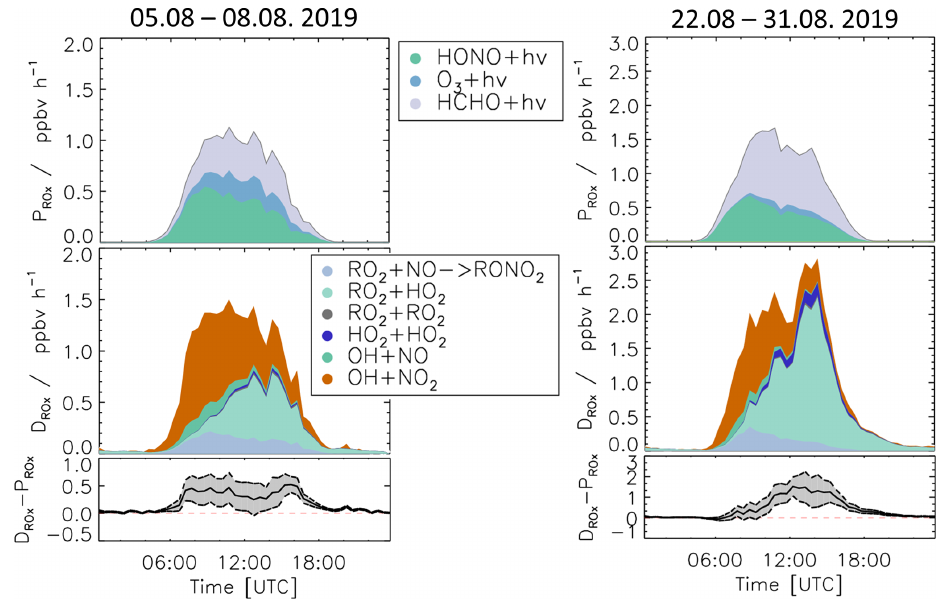
Figure 11. Production and destruction rates of RO X for the periods of the case studies (Case 1 and Case 2). In addition, the differences between the destruction and production rates are shown. Grey areas indicate the 1 σ uncertainty derived from experimental errors of the measured quantities (Table 2) and of the reaction rate constants (Table 1). The reactions that have insignificant contributions to the production or destruction rates are not